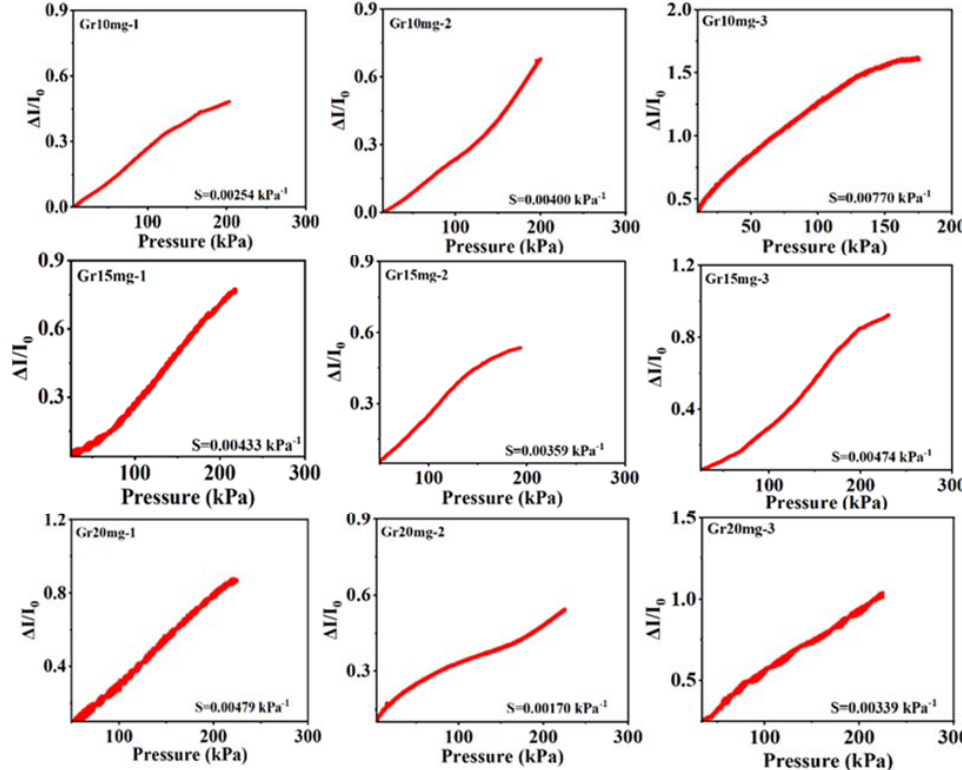
Figure 6. Sensitivity test results of Gr10 mg-1, Gr10 mg-2, Gr10 mg-3, Gr15 mg-1, Gr15 mg-2, Gr15 mg-3, Gr20 mg-1, Gr20 mg-2, and Gr20 mg-3. The S in figures stand for sensitivity.